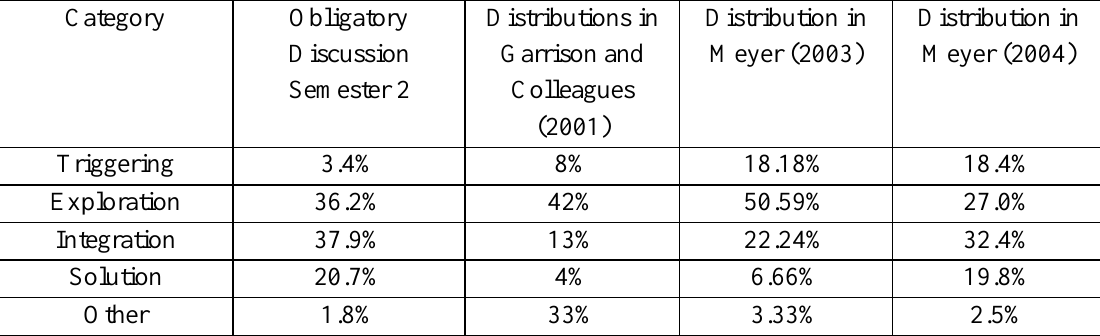
Comparison of Results